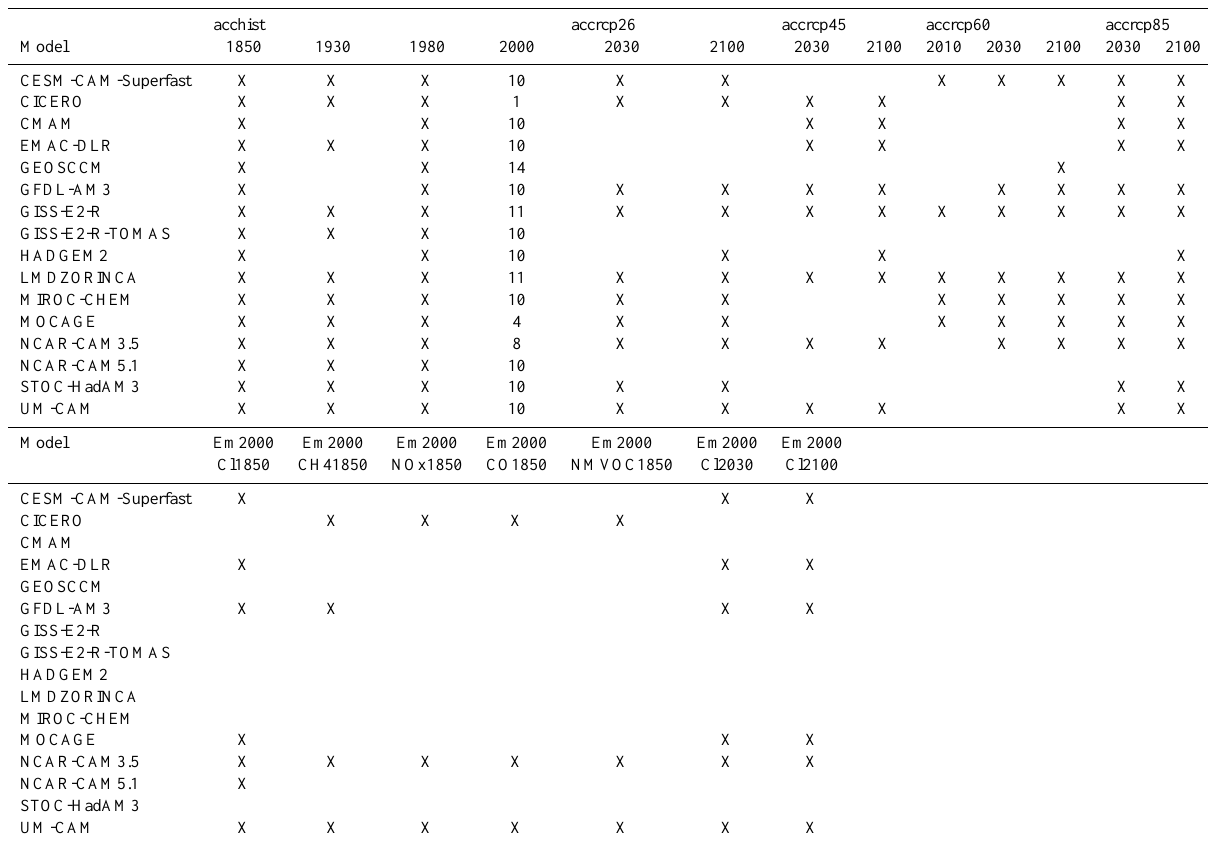
Table 2. List of participating models to and ACCMIP simulations performed. The number of years (valid for each experiment) is listed in the acchist 2000